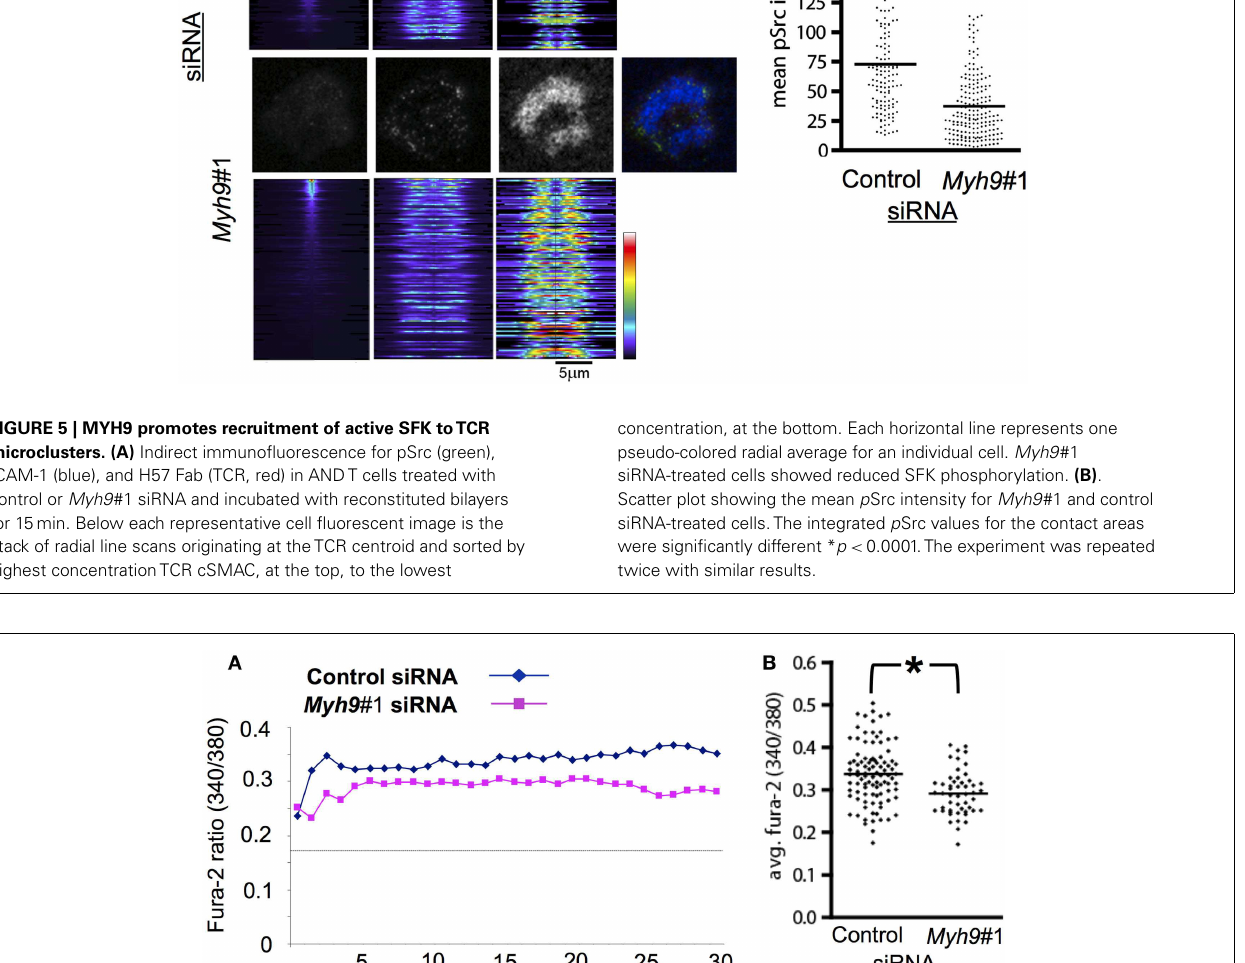
Fura-2 ratio for ANDT cells on bilayers with ICAM-1 alone. (B) The average (integrated) Fura-2 ratio from 0 to 30min with one data point for each cell. Under these conditions of labeling and imaging the average cellular baseline of Fura-2 on bilayers with ICAM-1 alone is 0.17 and the maximal ratio in the presence of ionomycin and 2mM extracellular Ca 2 + is 1.2. * Myh9 #1 siRNA reduced the average Ca 2 + by 27% ( p < 0.0001).The experiment was repeated twice with the same